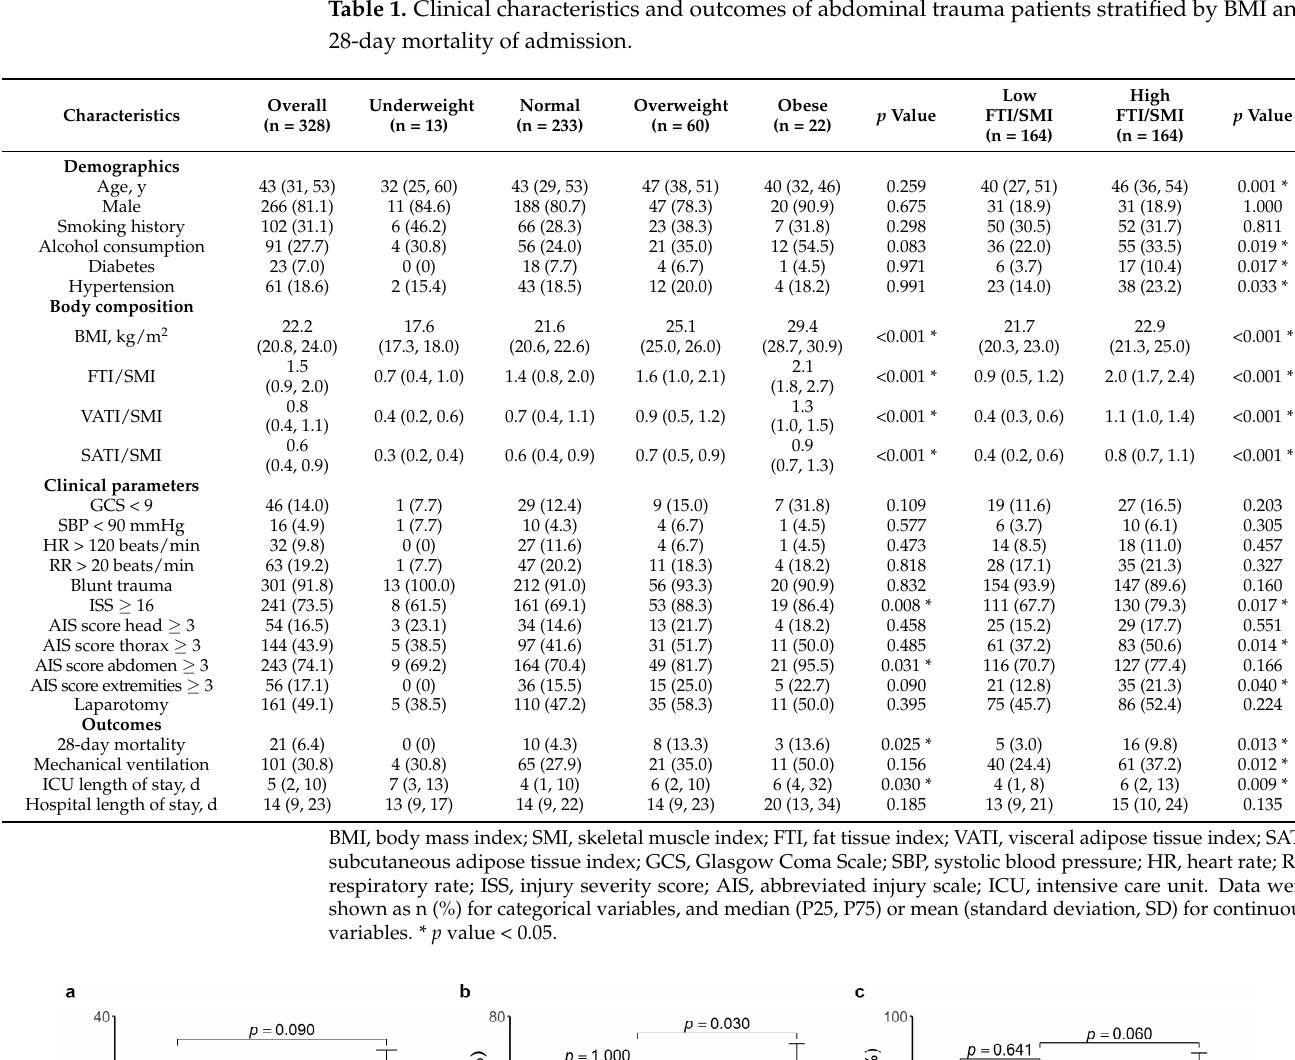
Table 1. Clinical characteristics and outcomes of abdominal trauma patients stratified by BMI and 28-day mortality of admission.